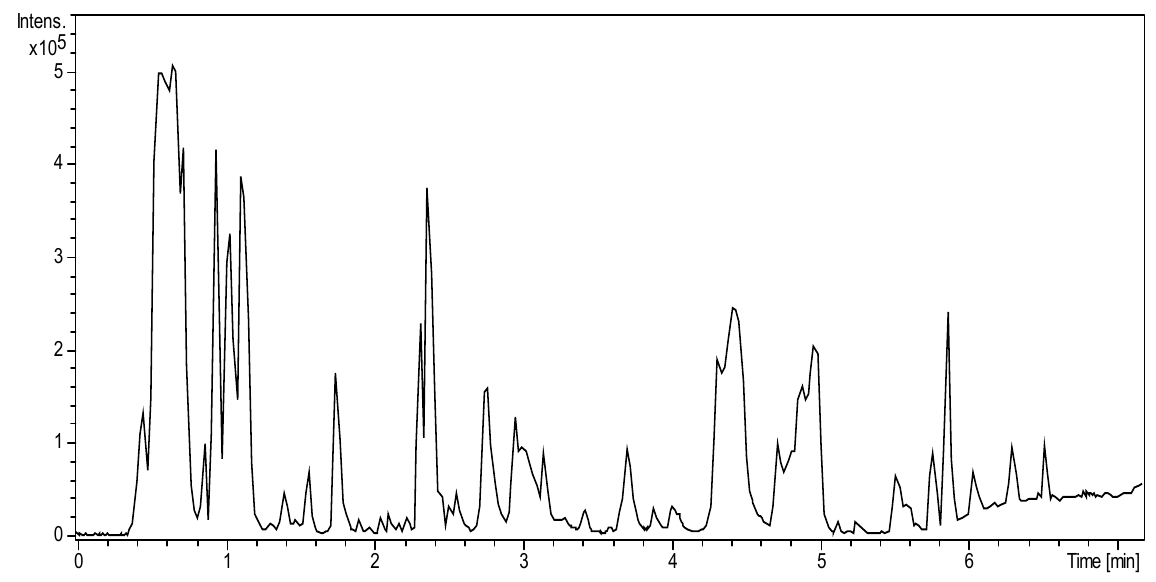
Figure 1. Base peak chromatogram in negative electrospray ionization of corn silk extract.